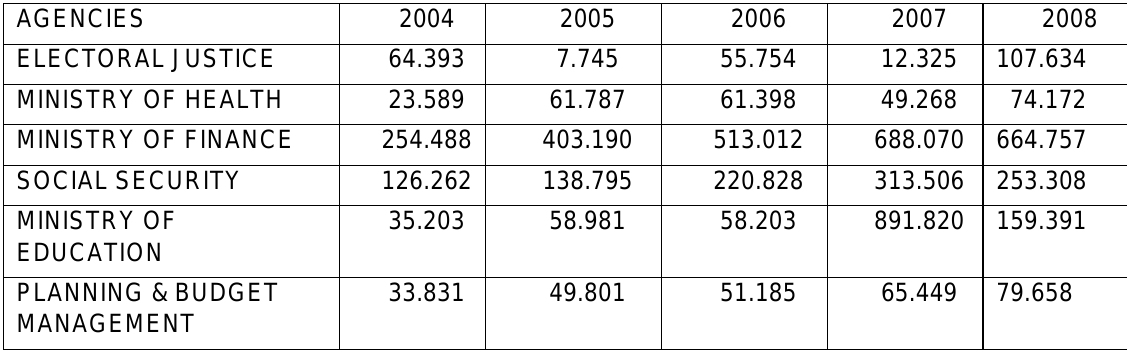
Table 1: Expenditures on Information Technology by Government Agencies (Value in Million US$) 1